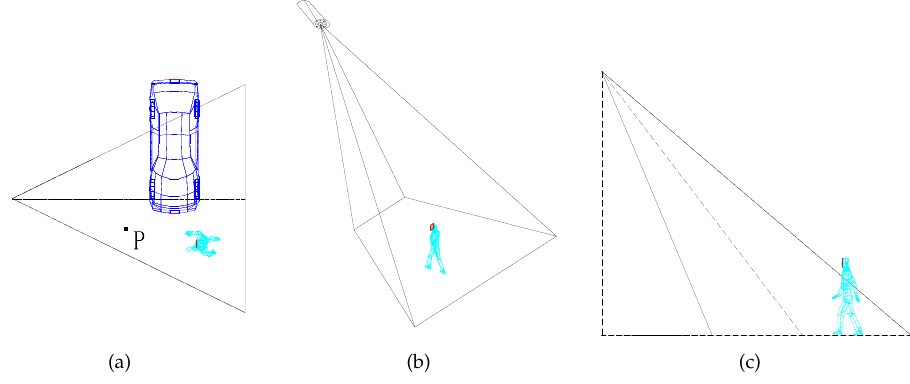
Figure 1. ( a ) There are three different types of targets (a point P, a car and a person) in the sensing area of the camera sensor. Obviously, it is not appropriate to use points to express different